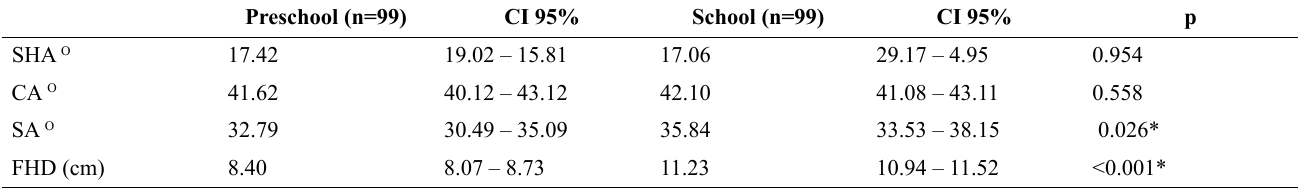
Table 2. Postural variables analyzed in sagittal plane in assessment (preschool) and reassessment (school). Preschool (n=99)